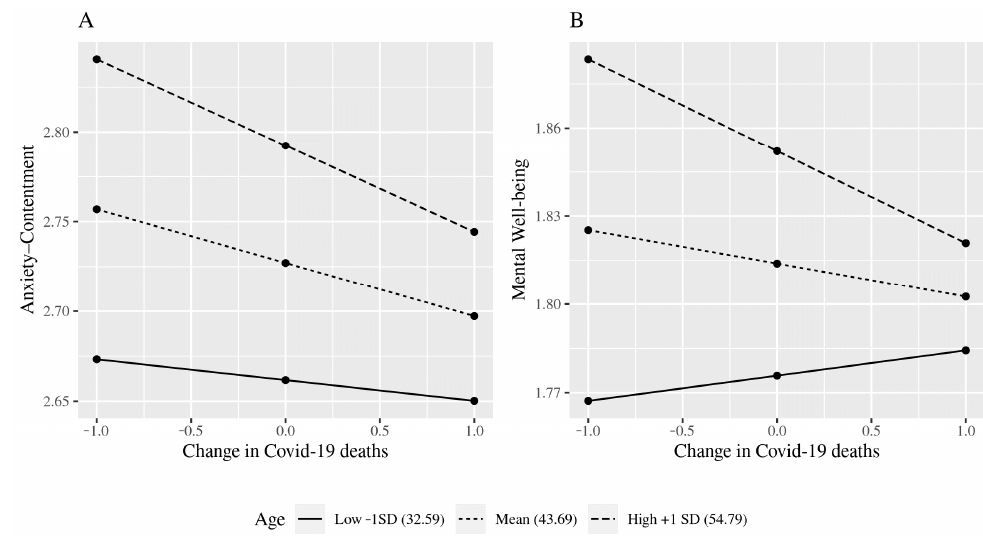
Figure 1. Interaction effects between Change in COVID-19 deaths and Age. ( A ) Anxiety-Contentment. ( B ) Mental Well-being.